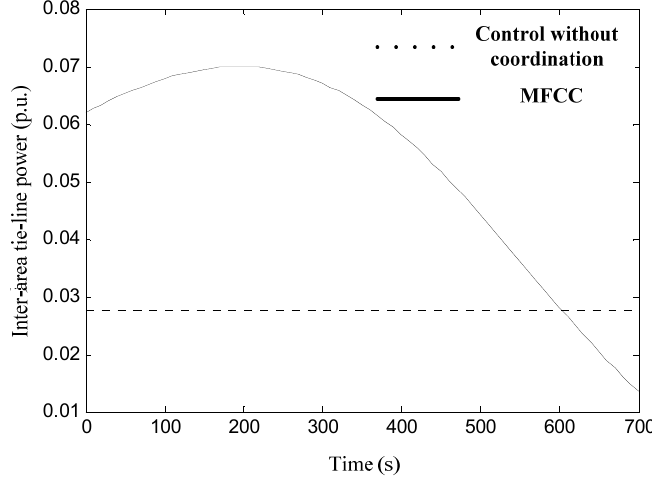
Figure 12. Ratio of power system under different delays.